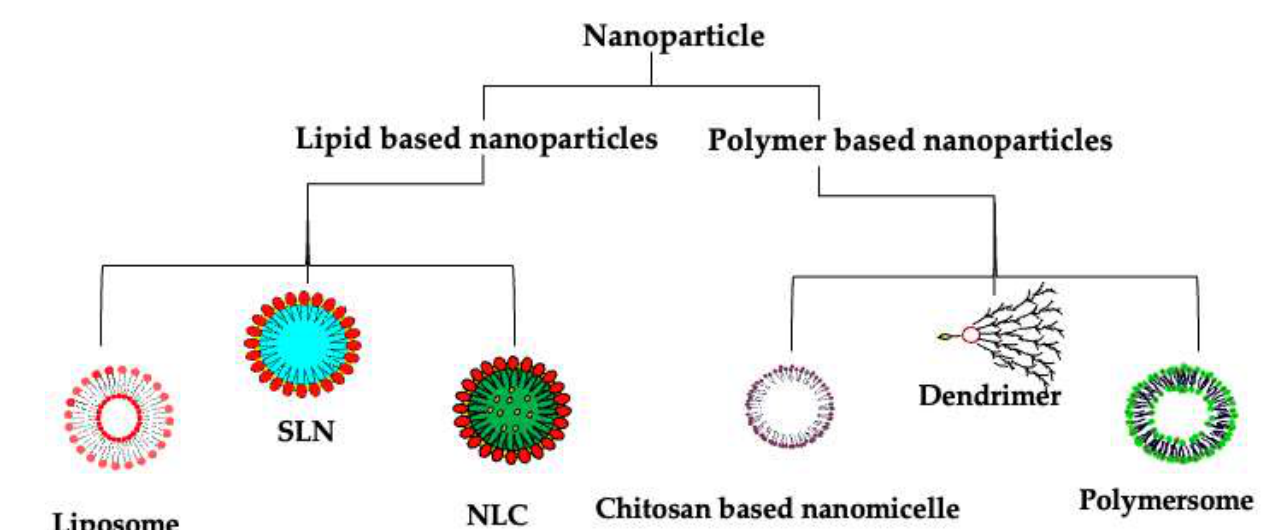
Figure 3. Current nanoparticles explored for neurogenic hypertension management. SLN; solid lipid nanoparticles, NLC; nanostructured lipid